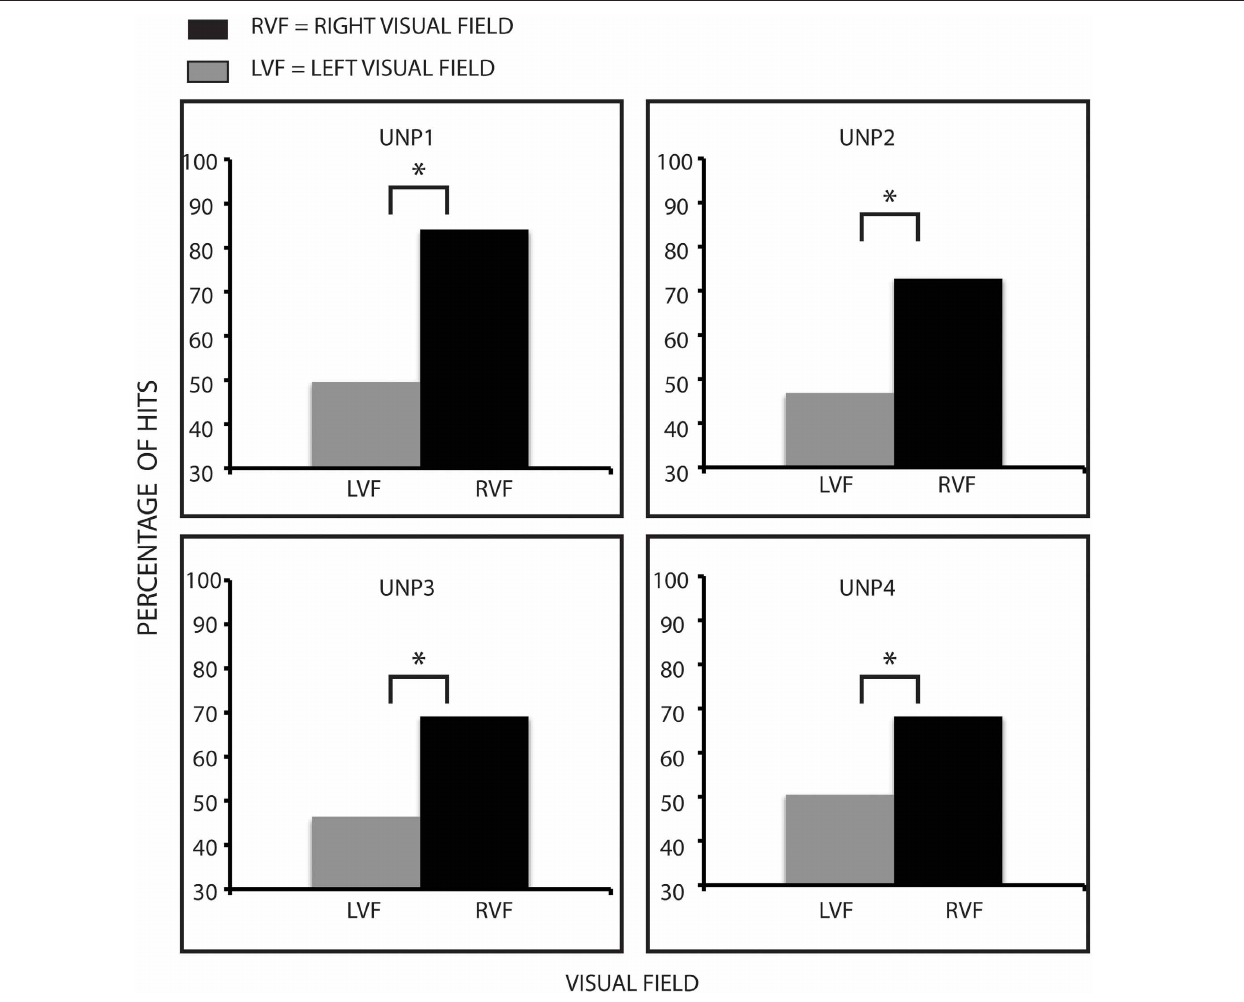
FIGURE 3 | Hit rate patterns for participants. Hits rates are lower on the left side compared to the right side, indicating that neglect patients have difficulty performing visual search. ∗ Denotes statistical significance of at least p < 0 .